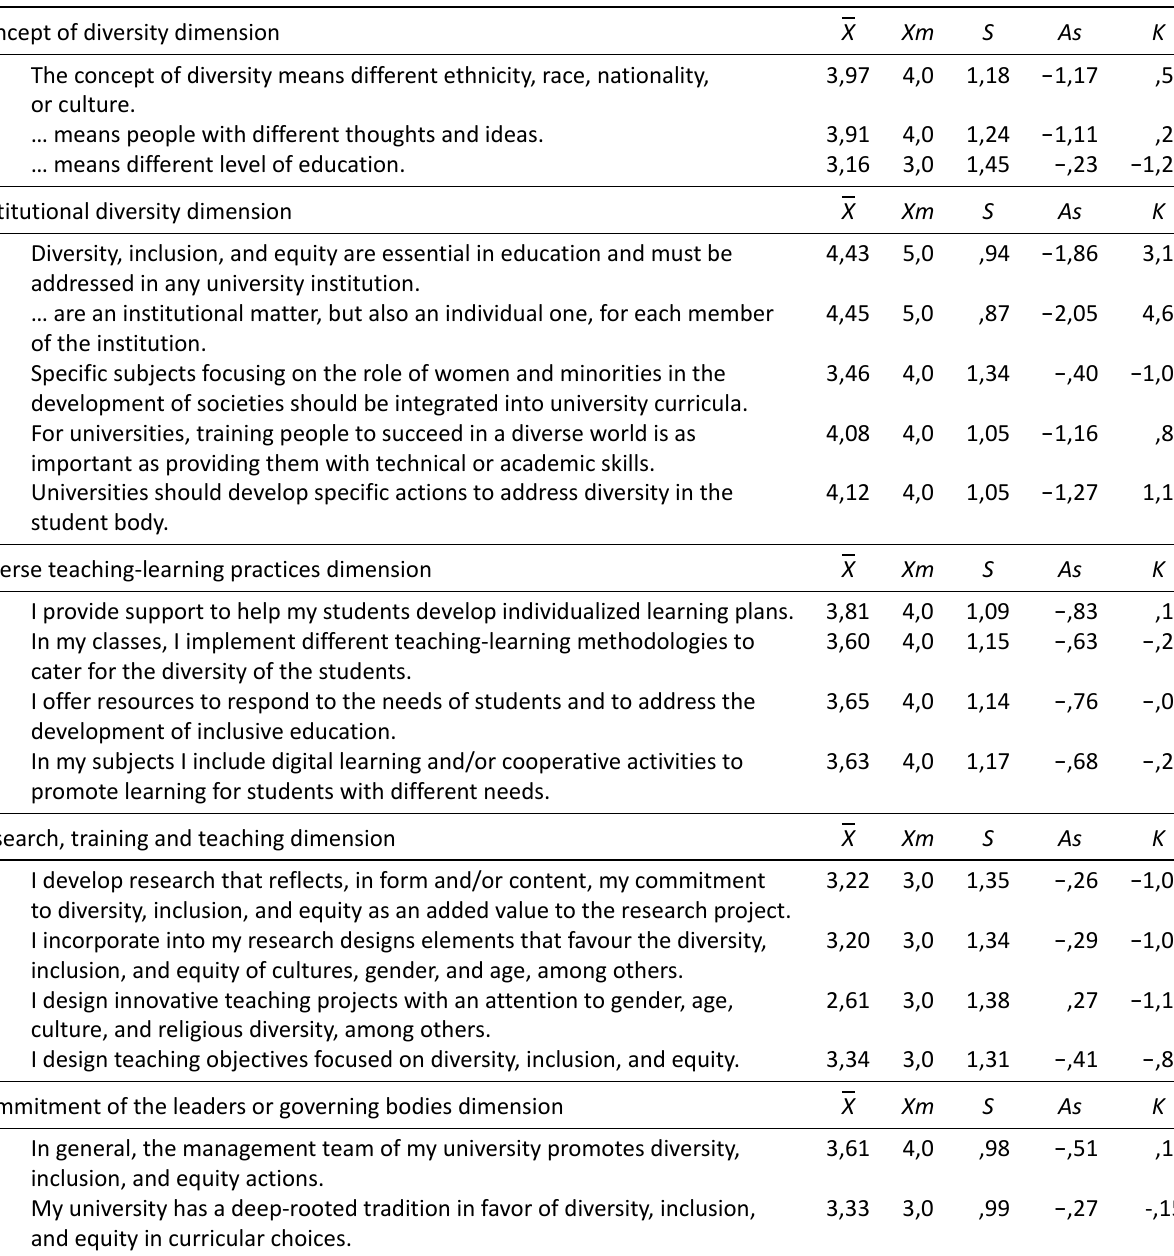
Table 2. Descriptive